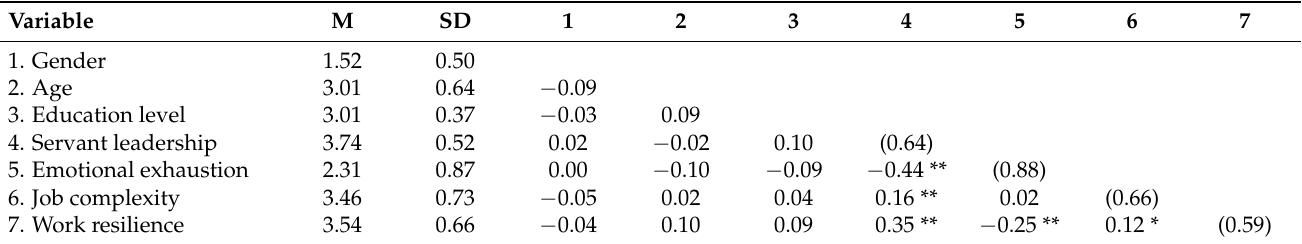
Table 3. Means, standard deviations, and